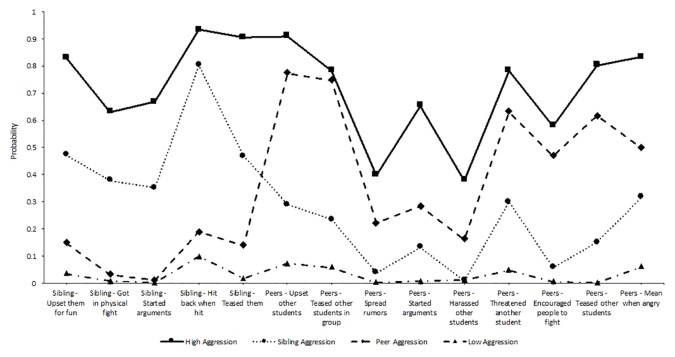
Latent class probabilities for a 4 class solution with sibling and peer aggression (waves 3 and 4).